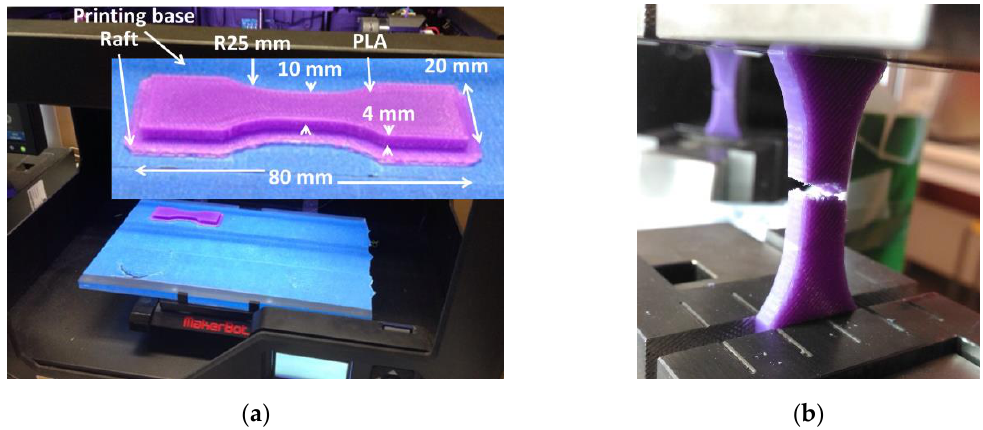
Figure 1. Tensile specimen printed using FDM: ( a ) Sample dimensions; ( b ) result of tensile testing.